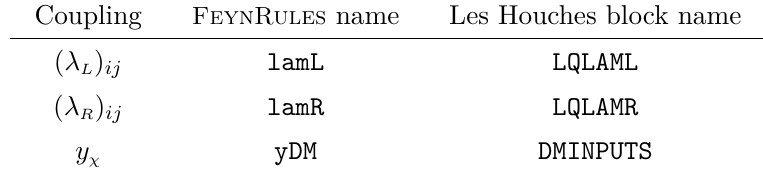
Table 6 . New physics couplings beyond the SM, given together with the associated FeynRules symbol and the Les Houches block name that can be refered to when using the model with a high- energy physics numerical